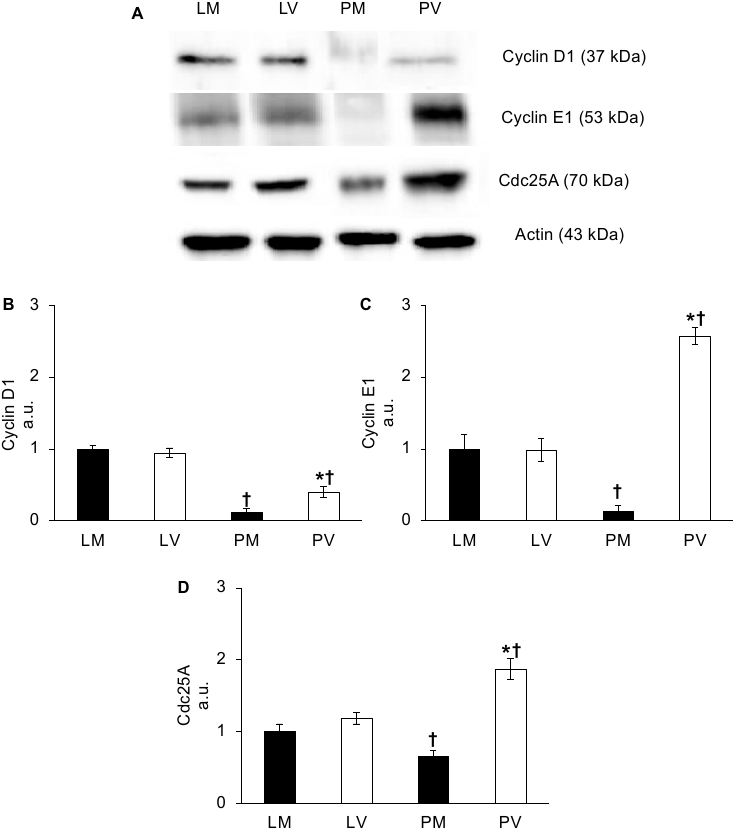
Figure 4. Cell cycle regulator (cyclinsD1 and E1, and Cdc25A) protein content in whole mice ova-